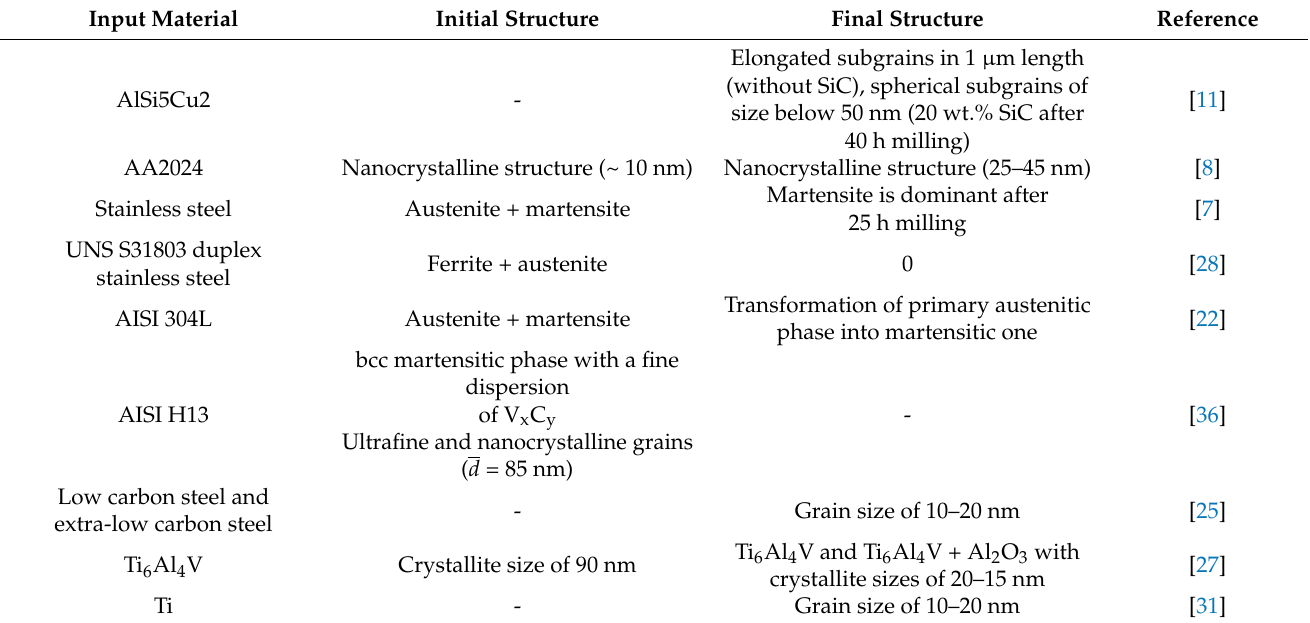
Table 4. Structure of milled